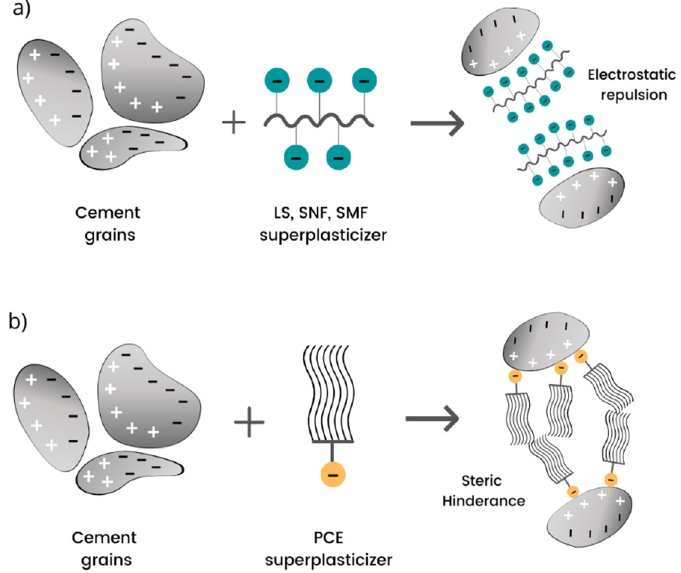
Figure 4. Schema: ( a ) electrostatic repulsion effect of cement; ( b ) steric hindrance mechanism, (adapted from [51]).